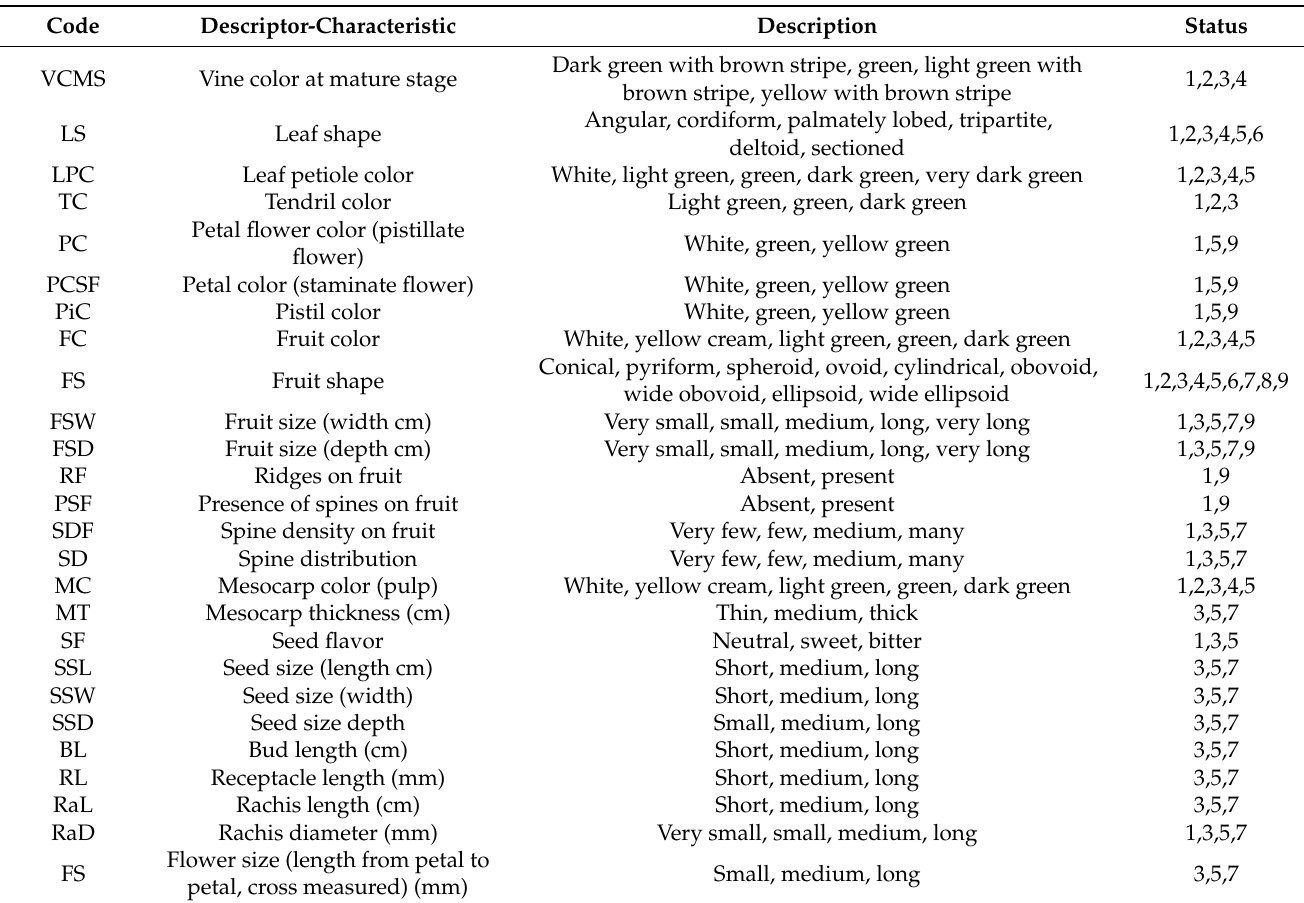
Table 3. Proposed descriptors to carry out the test for distinction, uniformity, and stability (DHE) in underutilized varieties of Sechium edule